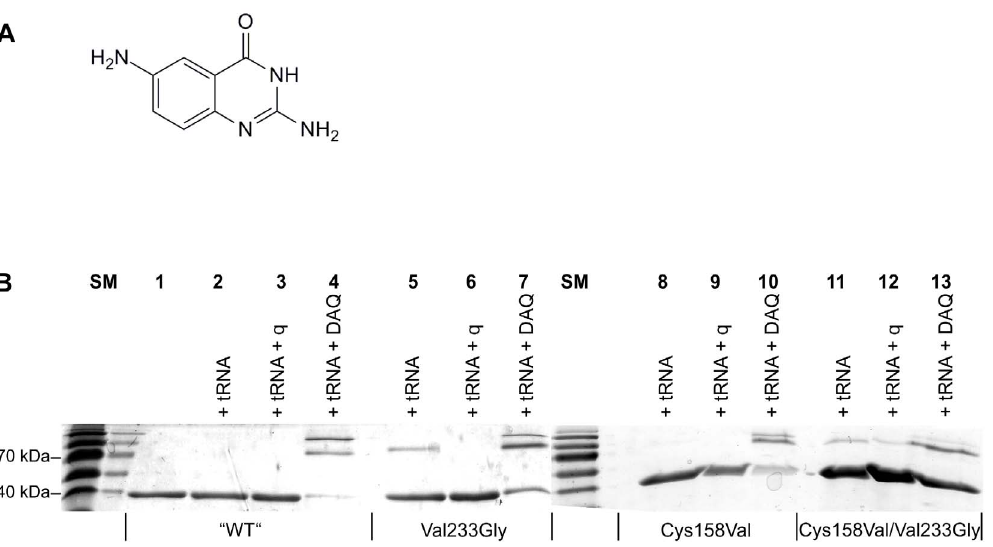
Figure 6. Trapping experiments performed with Tgt/tRNA mixtures in presence of queuine or 2,6-diamino-3 H -quinazolin-4-one. A) Chemical structure of 2,6-diamino-3 H -quinazolin-4-one (DAQ), an uncompetitive inhibitor of Tgt. B) SDS-PAGE analysis of reaction mixtures of Tgt or mutated variants thereof and tRNA Tyr under conditions indicated. SM, size marker; q, queuine. While DAQ causes retarded Tgt bands by stabilising the covalent Tgt ? tRNA intermediate, queuine lacks this ability for most of the investigated Tgt variants. Solely in case of Tgt(Cys159Val/Val233Gly) a faint retarded band is visible indicating that queuine may to some extent be able to bind to the guanine 34/preQ 1 subpocket of the covalent enzyme ? tRNA